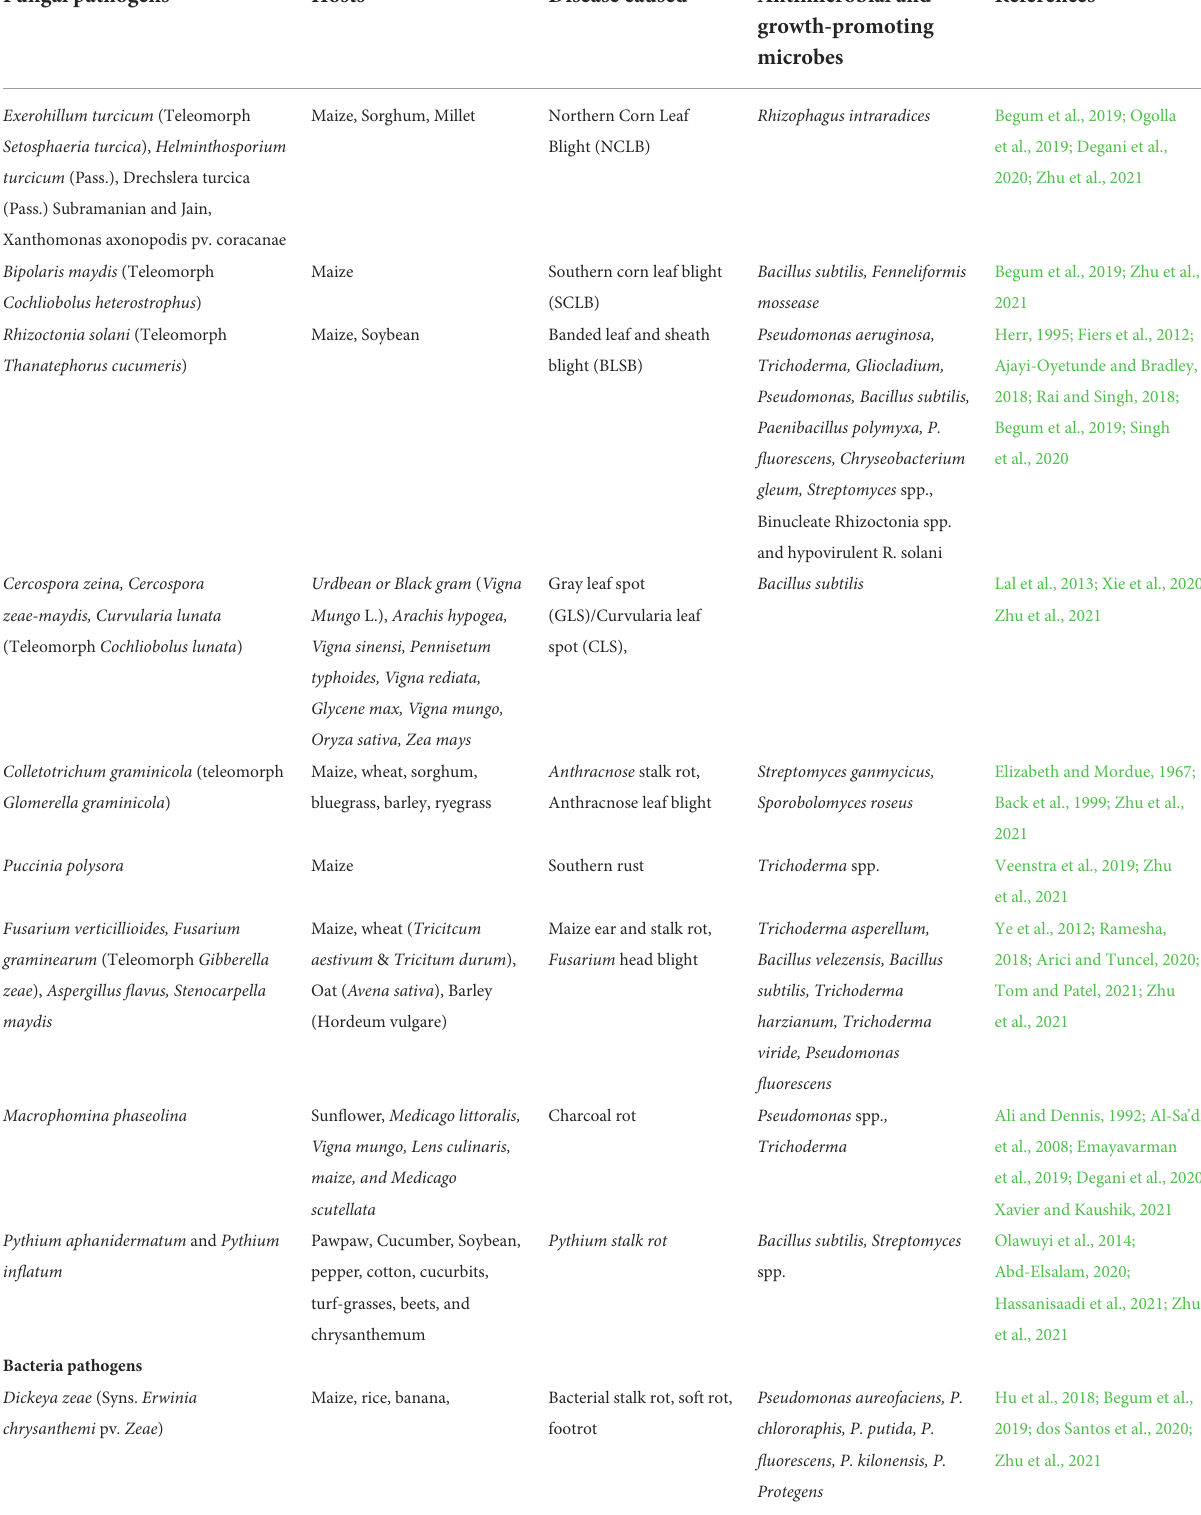
TABLE 1 Fungal and bacteria pathogens, diseases caused, and biological agents for managing agricultural